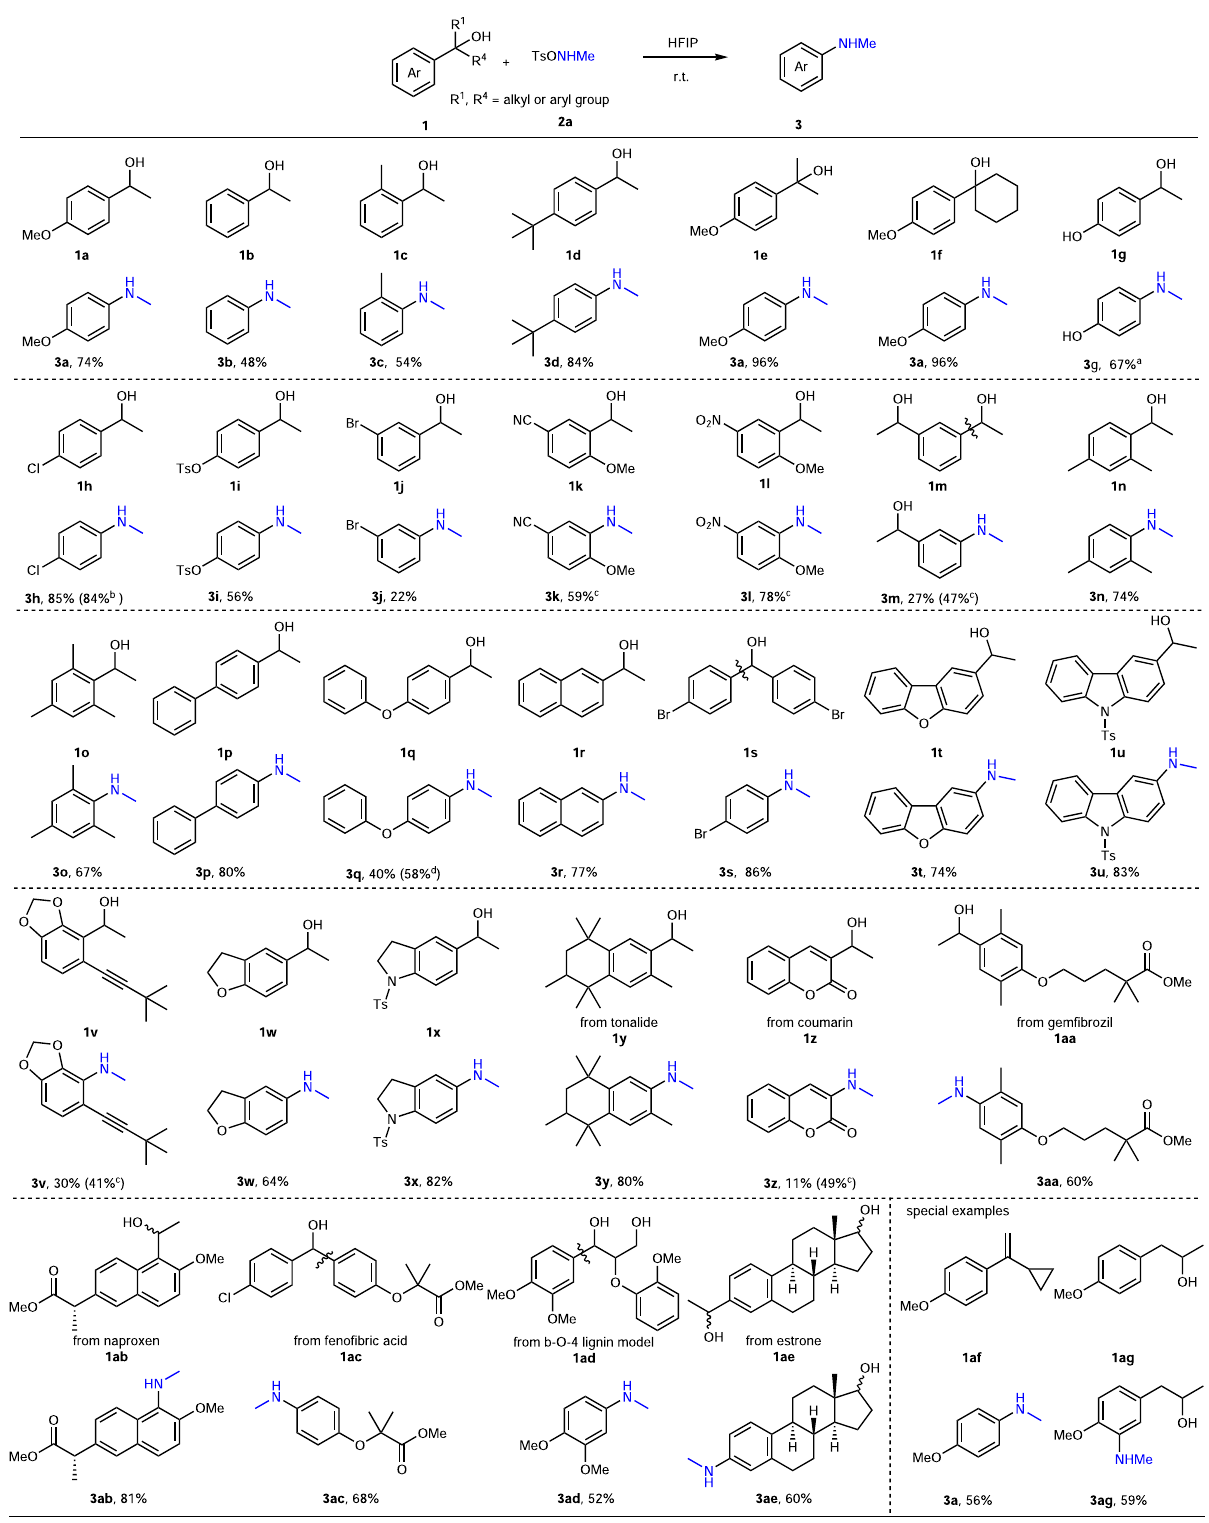
Fig. 2 Scope with regard to the alcohol in the synthesis of secondary anilines. Reaction conditions: alcohol (0.2 mmol), 2a (0.22 mmol), HFIP (hexa fl uoroisopropanol) (1.0 mL), 12 h, r.t.; a MsONHMe (Ms = methanesulfonyl) ( 2b , 0.22 mmol) instead of 2a ; b 1 h (4 mmol), 2a (4.4 mmol), HFIP (20 mL); c 2a (0.44 mmol), HFIP (0.5 mL); d 2a (0.26 mmol) was used; Ts